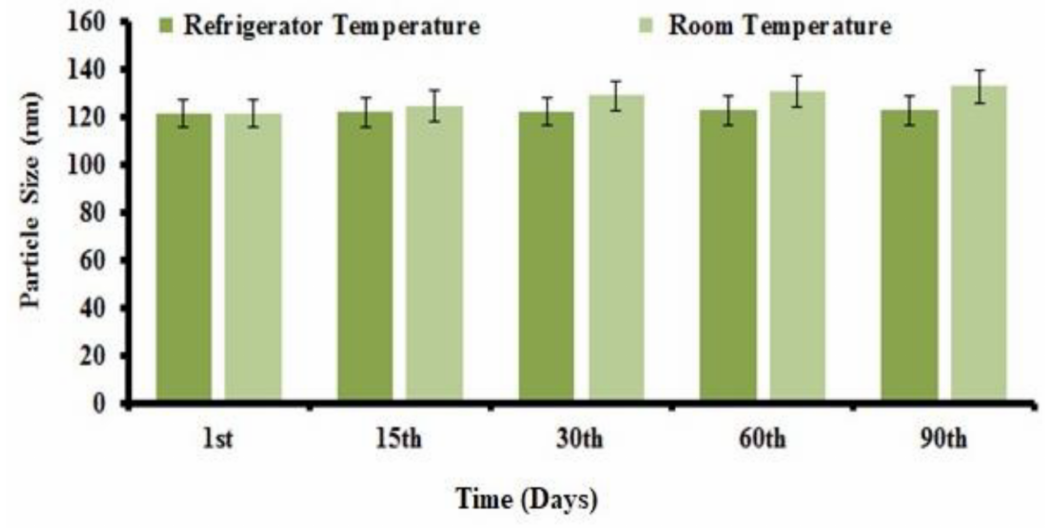
Figure 7. Particle size distribution of NOR-5 as a function of time. Refrigerated temp; (4 ◦ C) and Room Temp; (25 ◦